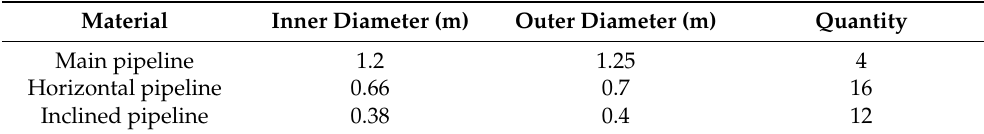
Figure 16. The effects of periodic structure height on cushioning performance (periodic structure width of 60 mm). The axial damping performance of the pipeline when the width of the periodical pipeline local resonance structure is unchanged at 80 mm, and the height of the periodical structure is 20 mm and 30 mm, respectively is shown in Figure 17. It can be seen from Figure 17 that the height of the periodic structure is 20 mm and 30 mm, and there are two band gaps in the frequency range of 0–1000 Hz. With the increase of the height of the period structure, the damping effect of the pipeline is also improved.